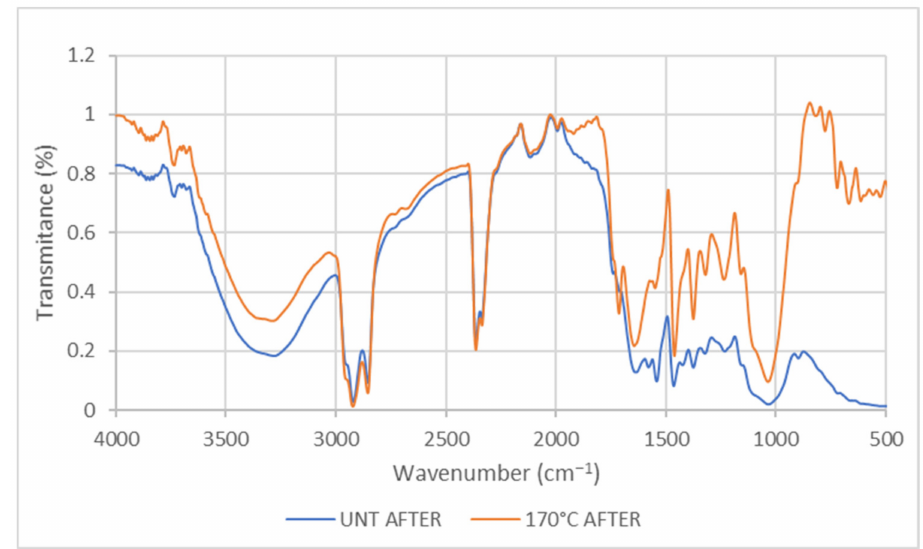
Figure 3. Comparison of IR spectra between EFB untreated and treated with 170 ◦ C samples after wetting with oil. UNT: